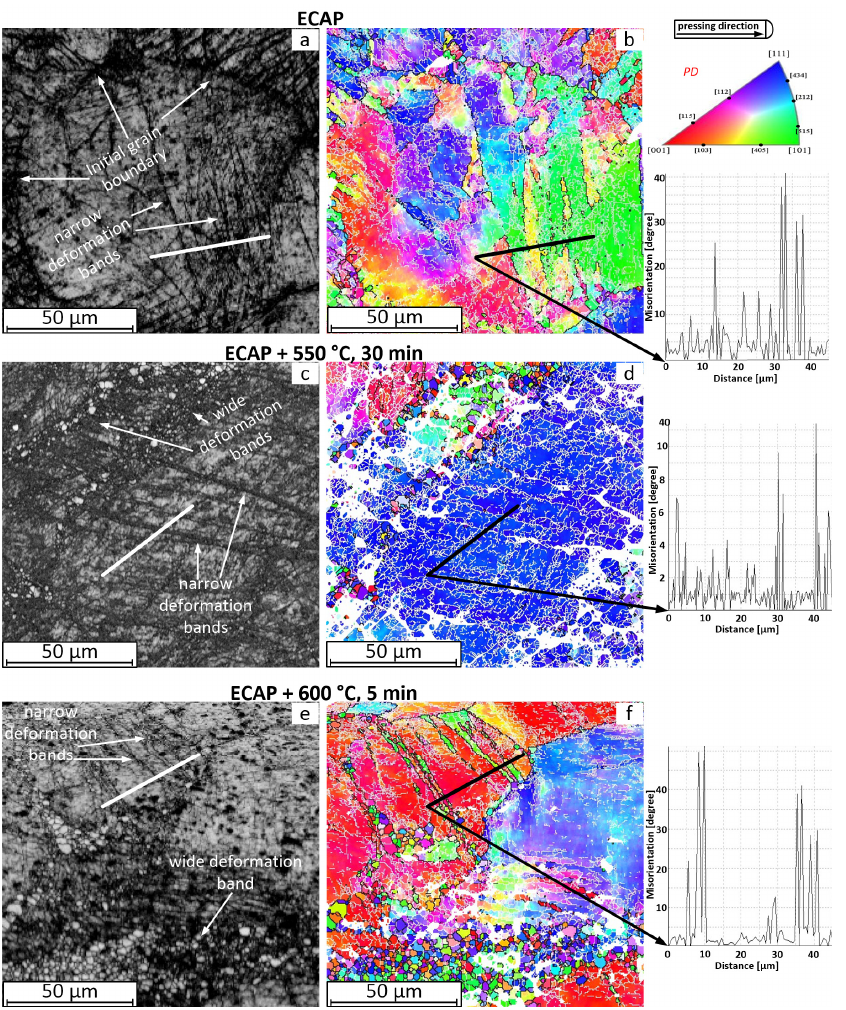
Figure 4. Results of microstructure and texture analyses of Ti ‐ 18Zr ‐ 15Nb: ( a , b ) ECAP, ( c , d ) ECAP + PDA 550 °C, 30 min, and ( e , f ) ECAP + PDA 600 °C, 5 min; SEM images ( a , c , e ), EBSD images ( b , d , f ). Black lines correspond to high ‐ angle boundaries (>15°), white lines, to low ‐ angle boundaries (2–15°). PD—pressing direction.